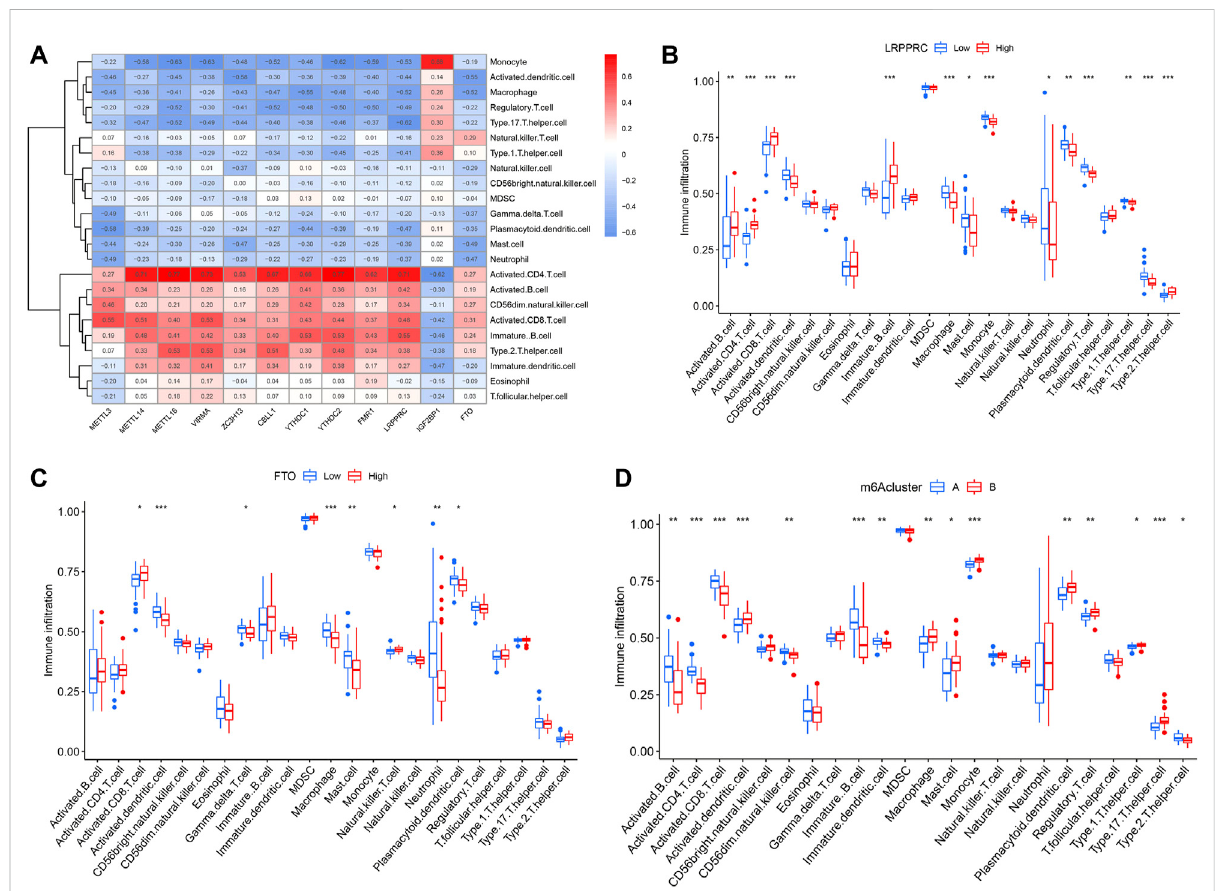
FIGURE 7 SinglesampleGSEAforimmunein fi ltration. (A) Heatmaprevealingrelationshipbetweenimmunecellsandthe12signi fi cantm6Aregulators. (B) Distinction of immune cells in fi ltration between high and low LRPPRC expression subgroups. (C) Distinction of immune cells in fi ltration between high and low FTO expression subgroups. (D) Distinction of immune cells in fi ltration between clusterA and clusterB. * p < 0.05, ** p < 0.01, and *** p <